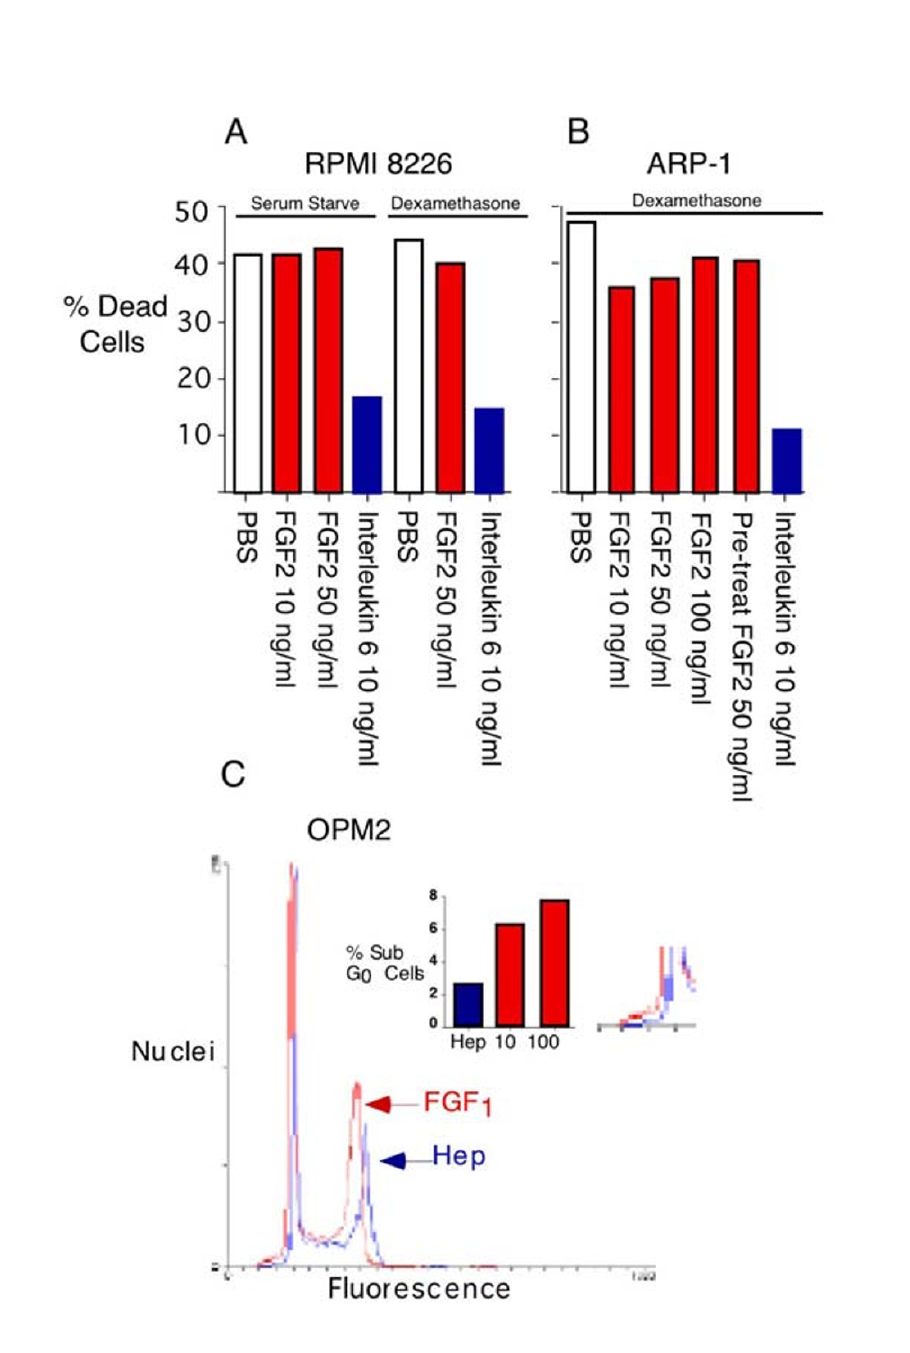
DNA content for 0 region shown in the 0